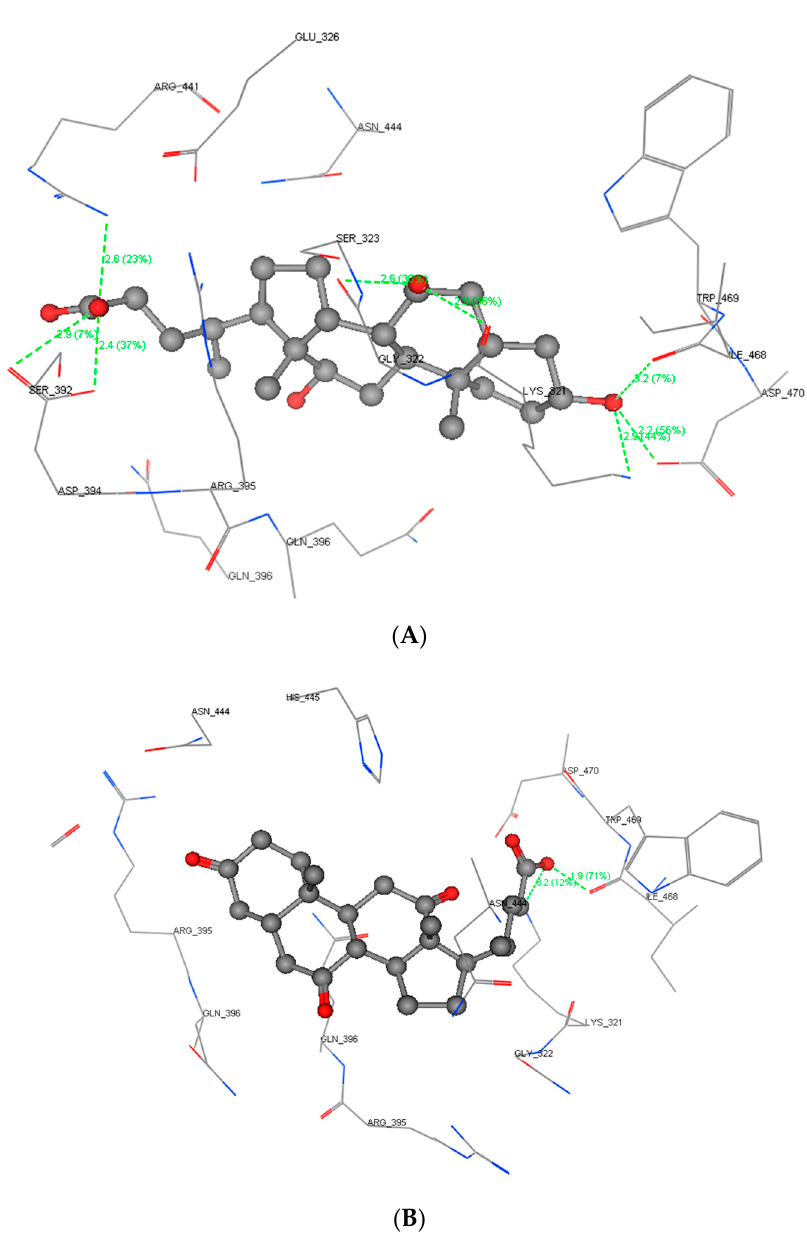
Figure 3. Theoretical Binding mode of compound cholic acid ( A ) and dehydrocholic acid ( B ) in bile acid receptor protein (PDB: 3bej) in three-dimensional (3D).